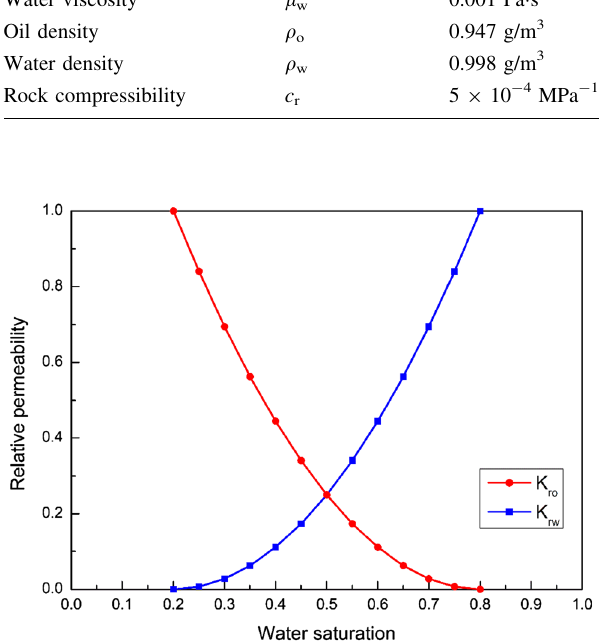
Fig. 3 Oil and water relative permeability curve